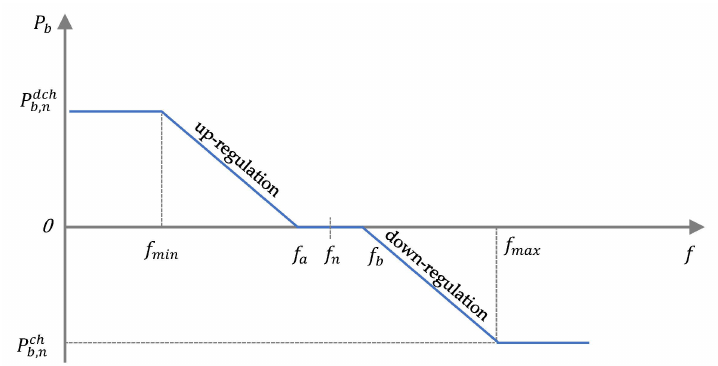
Figure 2. The action of the BESS for the primary frequency regulation